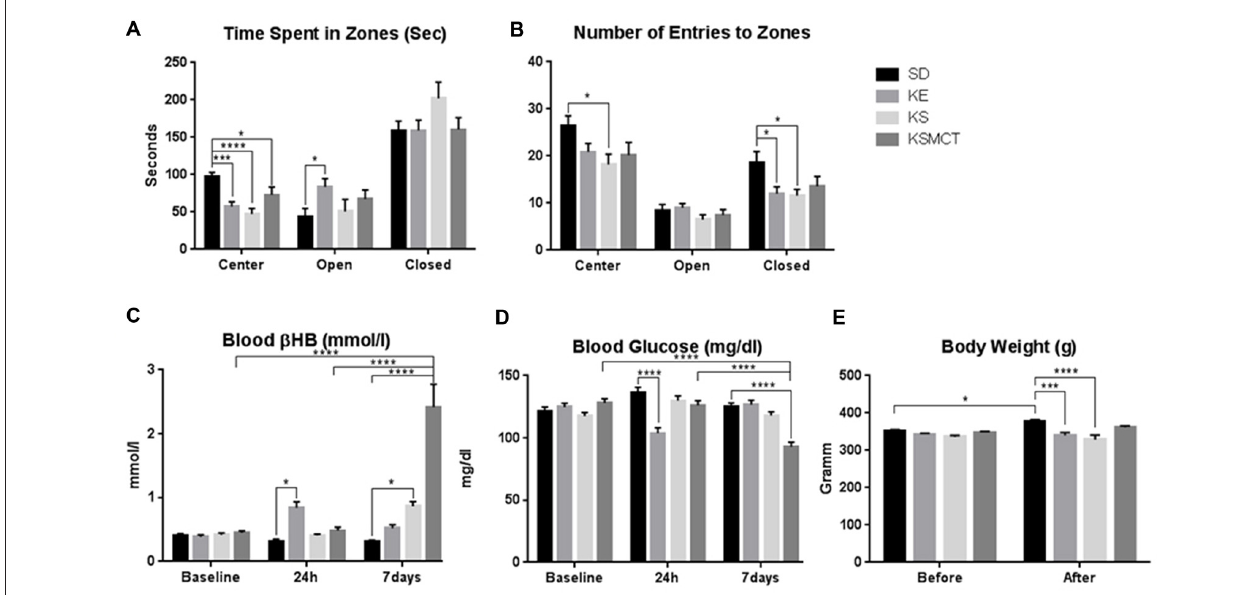
FIGURE 2 | Response of SPD rats to 7 days oral administration (gavage) of exogenous ketone supplementation. (A) More time spent in open arms (open) by KE group and less time spent in center by KE, KS and KSMCT groups were detected compared to control; (B) Less entries in closed arms (closed) by KE and KS groups; (C) Blood β HB levels were higher in KE group after 24 h and in KS and KSMCT groups after 7 days, compared to control; (D) Blood glucose levels were lower in KE group after 24 h and in KSMCT group compared to baseline, control and 24 h; (E) Body weight was lower in KE and KS groups compared to control after 7 days. Abbreviations: SD, standard rodent chow + water ( ∼ 5 g/kg b.w. water/day); KE, SD + ketone ester (1,3-butanediol-acetoacetate diester, ∼ 5 g/kg b.w./day); KS, SD + beta-hydroxybutyrate-mineral salt ( β HB-S; ∼ 5 g/kg b.w./day); KSMCT, SD + β HB-S + MCT ( ∼ 5 g/kg b.w./day); ( ∗ p < 0.05; ∗∗∗ p < 0.001; ∗∗∗∗ p <